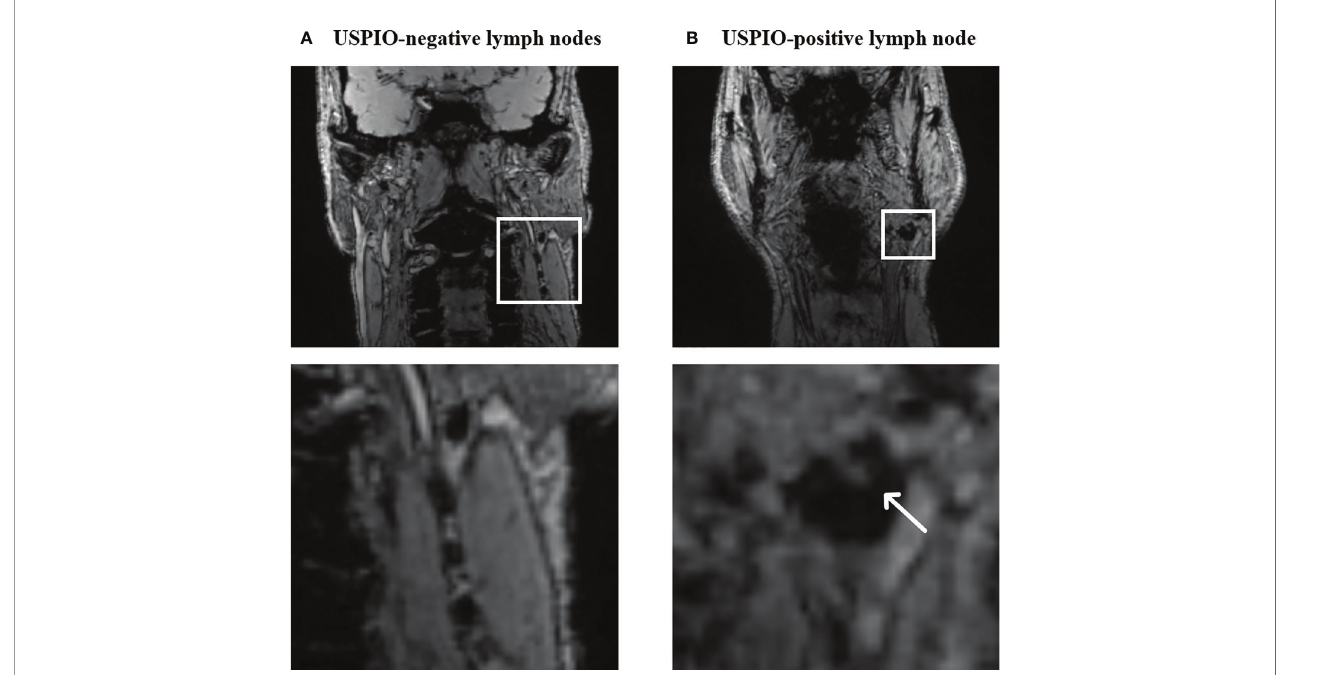
FIGURE 1 | MR characteristics of USPIO-negative lymph nodes (A) and a partially USPIO-positive lymph node (B) on a T2*-weighted iron-sensitive sequence (own unpublished data). The white arrow in (B) points out an area of increased signal intensity suspicious for a